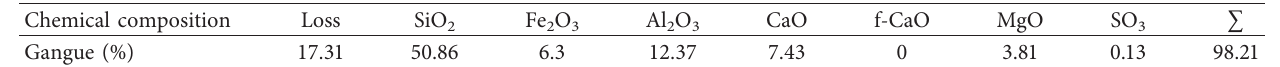
Table 2: Main chemical constituents of coal gangue.